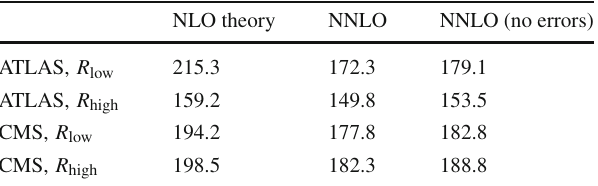
Table 4 The χ 2 for the combined NNLO fit to the ATLAS and CMS 7 TeV jet data, excluding and including the calculated NNLO K -factors, and excluding the errors associated with the polynomial fit to the K - factors. The p jet ⊥ factorization/renormalization scale is taken